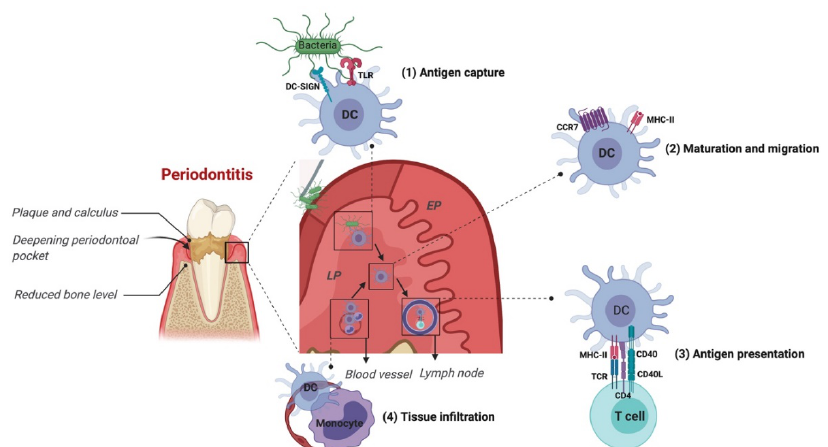
Figure 1. Microbial-dendritic cell (DC) interactions in diseased tissues of periodontitis. DCs recognize and uptake dysbiotic invasive pathogen Porphyromonas gingivalis by a combination of TLR2 and DC-SIGN. DCs migrate through lamina propria (LP) and undergo maturation process and acquire migratory profile. Semi-mature DCs ‘stall’ in the tissues, while fully mature DCs migrate to secondary lymphoid organs (SLO) to present antigens in the context of MHC molecules to T cells and activate the adaptive immune response. As maturing DCs efflux from tissues, blood inflammatory DCs and monocytes migrate into the tissues and di ff erentiate into DCs to replace migrating DCs and maintain proper DCs